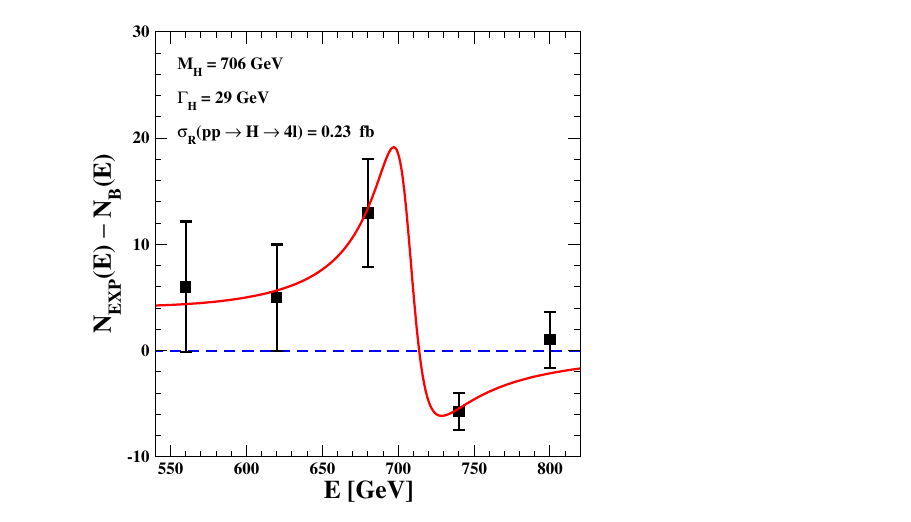
Figure 2. The values N EXP ( E ) − N B ( E ) in Table 1 vs. the corresponding N TH ( E ) − N B ( E ) (the red continuous line). The resonance parameters are M H = 706 GeV, γ H = 0.041, σ R = 0.23 fb and the ATLAS background is approximated as N B ( E ) = A · ( 710 GeV/ E ) ν with A = 10.55 and ν = 4.72. Table 2. We report the observed ATLAS ggF-low events and our theoretical prediction Equation (23) for M H = 706 GeV, γ H = 0.041, P =